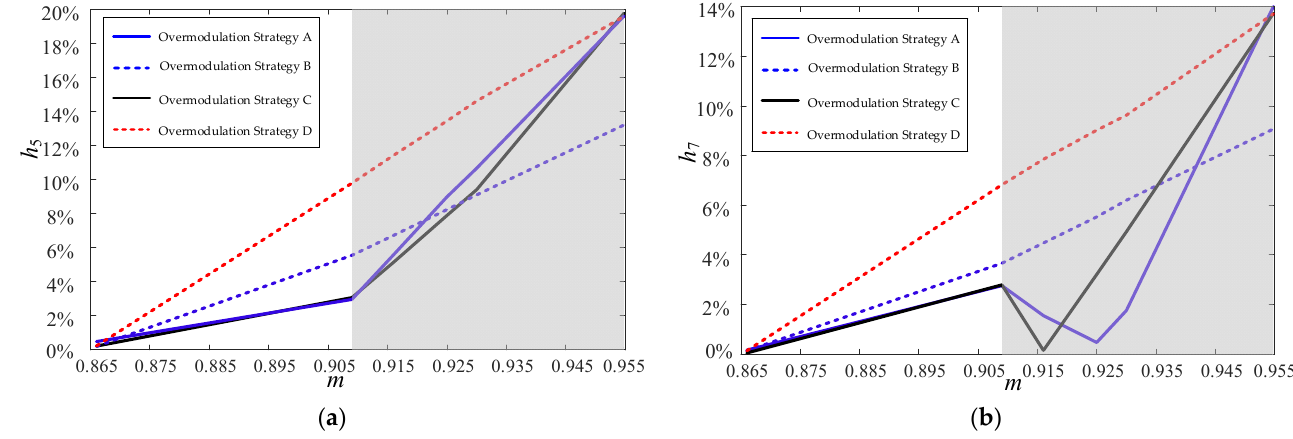
Figure 14. Experimental results of low ‐ order harmonic components: ( a ) 5th; ( b ) 7th.